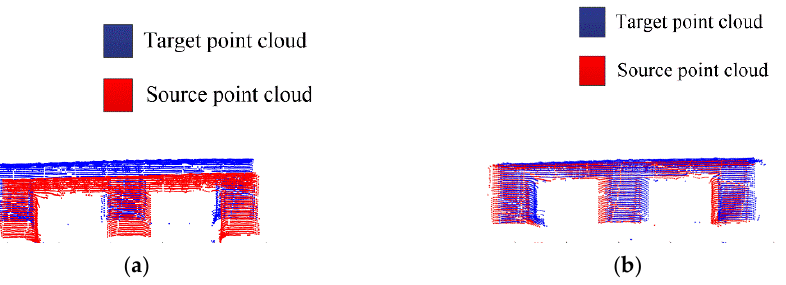
Figure 21. Comparison of coarse registration results between FPFH and AGWF. ( a ) Coarse registration based on FPFH. ( b ) Coarse registration based on AGWF.